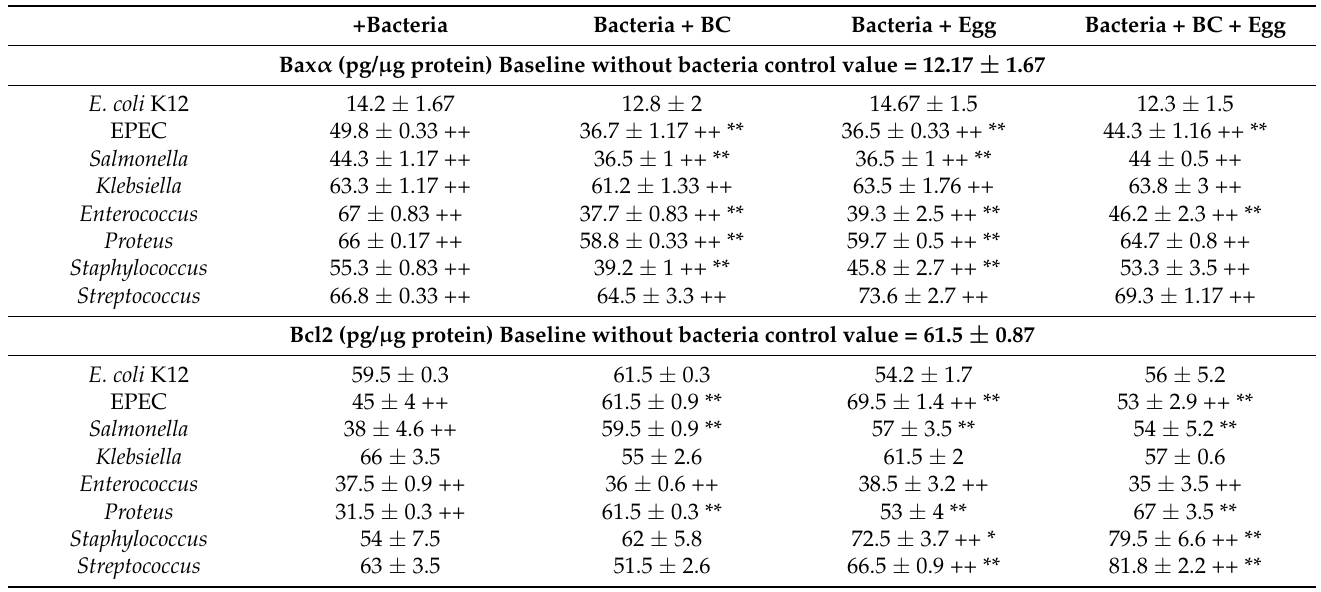
Table 2. Effect of BC alone, egg, or the combination on bacteria-induced changes in apoptosis signaling molecules. +Bacteria Bacteria + BC Bacteria + Egg Bacteria + BC + Egg